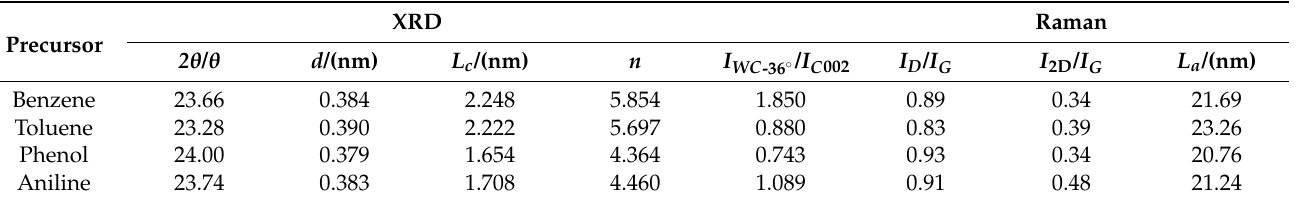
Figure 4. ( a ) XRD patterns; ( b ) Raman spectra; ( c ) XPS survey spectra of samples from benzene, toluene, phenol, and aniline; ( d ) high-resolution XPS scans of N 1 s peak for sample from aniline. Table 2. Structural parameters obtained from X-ray diffraction (XRD) and Raman characterization of all the samples synthesized by benzene, toluene, phenol, and